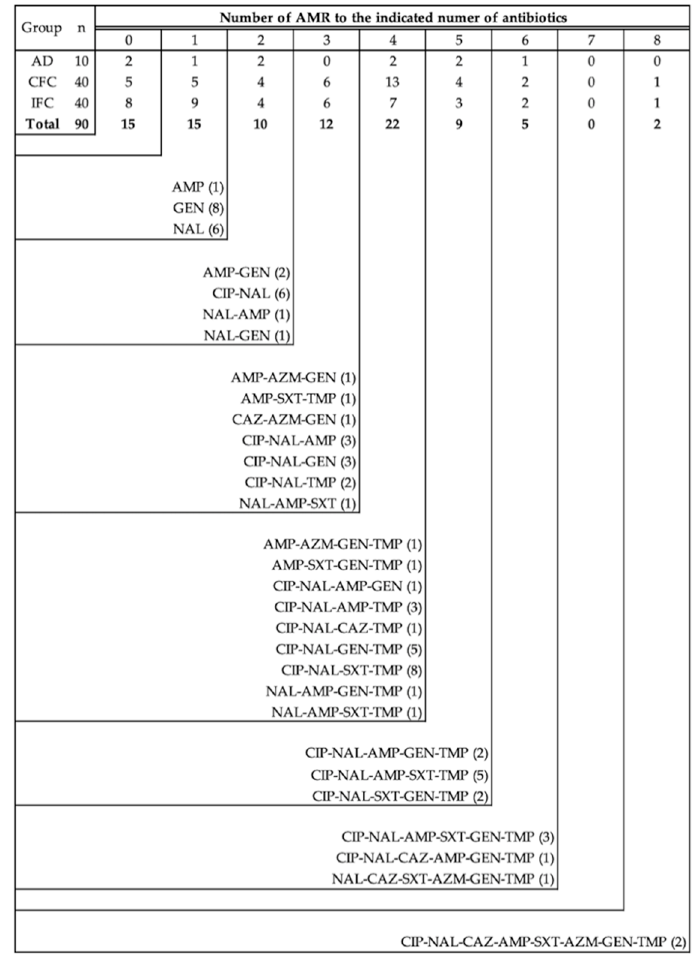
Figure 3. Number of E. coli strains isolated resistant to the different number of antimicrobials tested and their antimicrobial resistance pattern, according to commercial (CFC) and improved (IFC) farm conditions. n: total number of isolates from each experimental group. AMR: antimicrobial resistances, AD: arrival day, CFC: Commercial farm conditions, IFC: Improved farm conditions, CIP: ciprofloxacin, NAL: nalidixic acid, AMP: ampicillin, CTX: cefotaxime, CAZ: ceftazidime, CHL: chloramphenicol, SXT: trimethoprim-sulfamethoxazole, CST: colistin, AZM: azithromycin, TGC: tigecycline, GEN: gentamycin, TMP: trimethoprim.